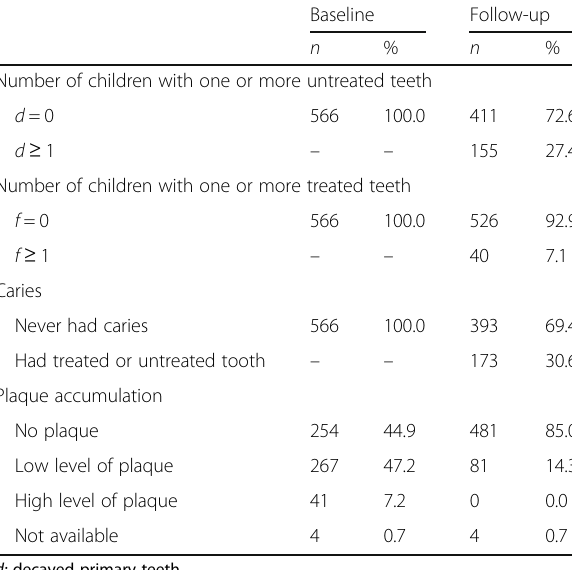
Table 2 Status of teeth at baseline and follow-up ( n = 566)